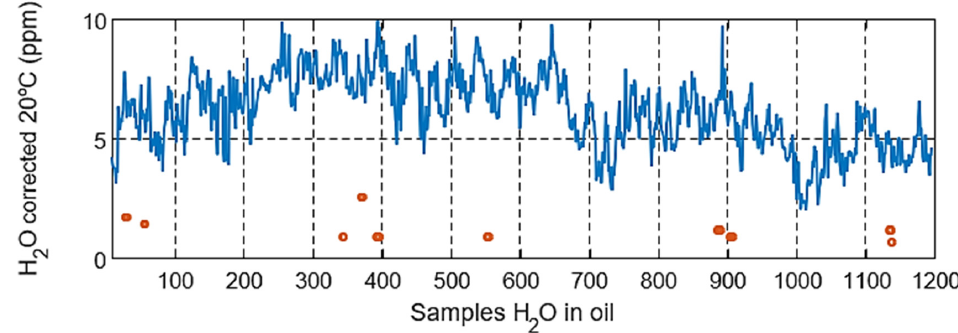
Figure 36. Evolution of water content in oil corrected to 20 °C, online (blue) and offline (orange) data.